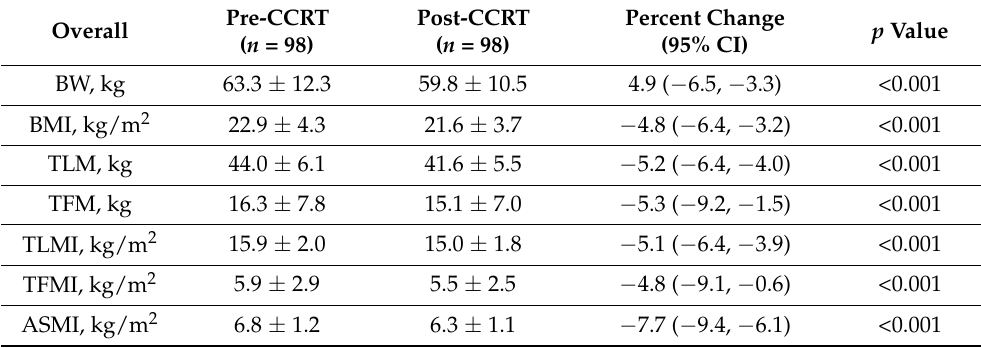
Table 3. Body composition changes before and after CCRT in patients with LAHNC.